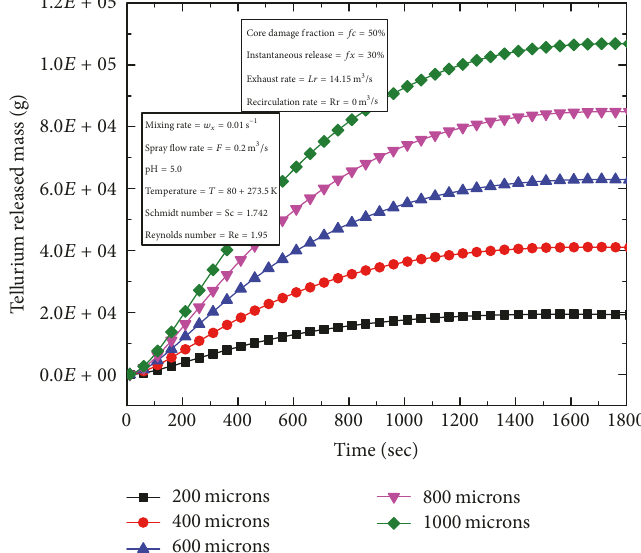
Figure 15: Radioactive tellurium mass released during in-vessel release phase with mixing rate 𝑤 푥 = 0.01s −1